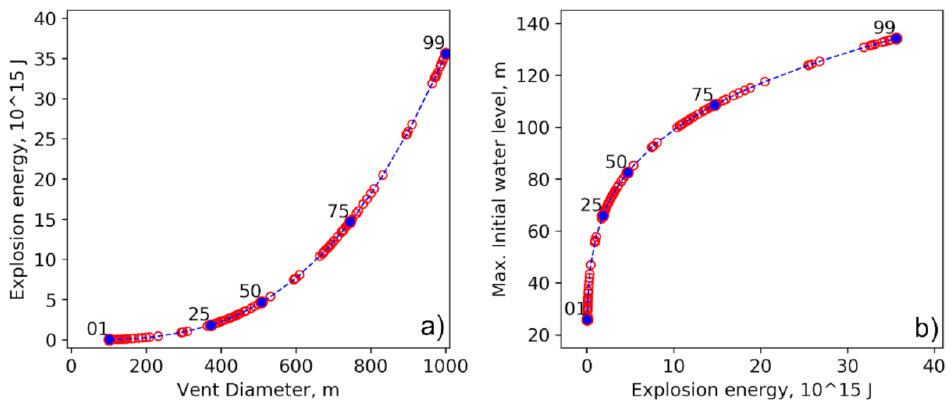
Figure 3. Scenarios of subaqueous volcanic explosions: ( a ) the relationship between vent size and explosion energy, ( b ) maximum initial water level related to explosion